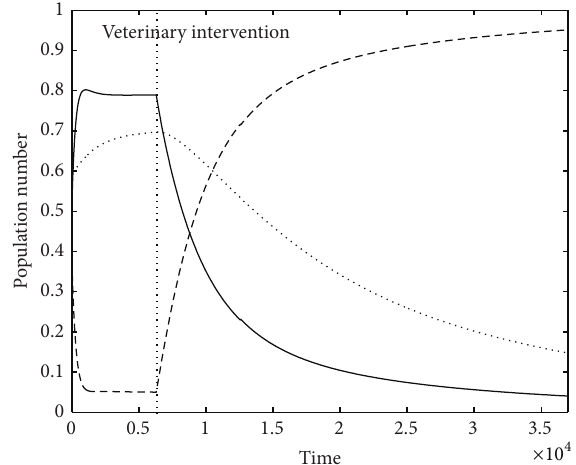
Figure 1: Dynamic of the bovine babesiosis disease. 𝐼 𝐵 (continuous line) together with 𝑆 𝐵 (dashed line) and 𝐼 𝑇 (dotted line) were shown as function of the time.